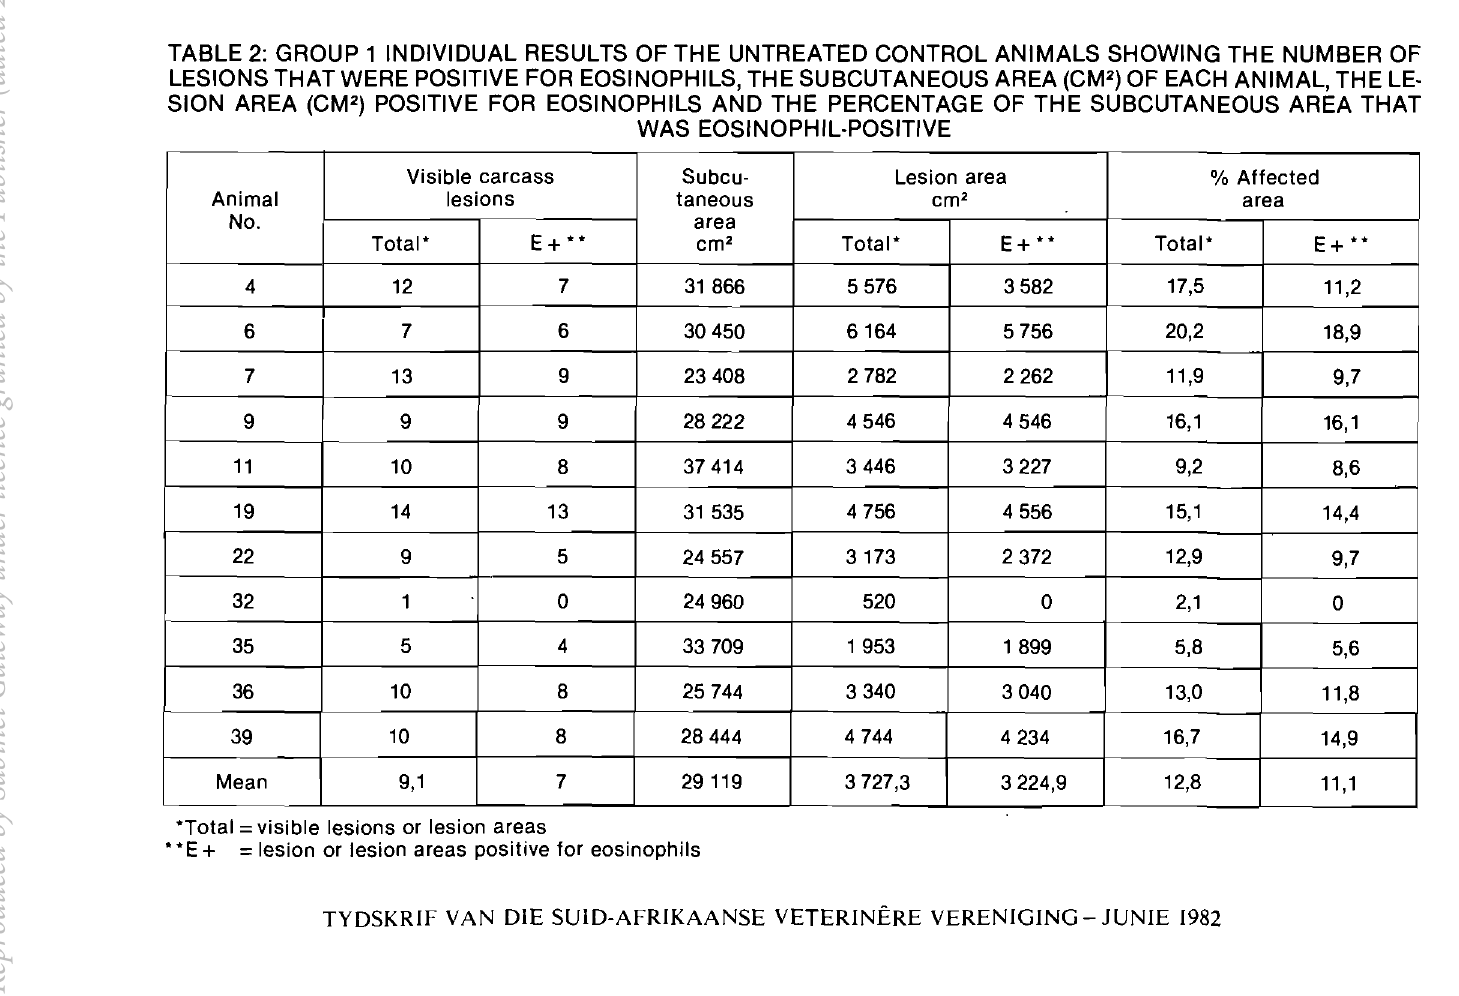
TABLE 2: GROUP 1 INDIVIDUAL RESULTS OF THE UNTREATED CONTROL ANIMALS SHOWING THE NUMBER OF LESIONS THAT WERE POSITIVE FOR EOSINOPHILS, THE SUBCUTANEOUS AREA (CW) OF EACH ANIMAL, THE LE SION AREA (CW) POSITIVE FOR EOSINOPHILS AND THE PERCENTAGE OF THE SUBCUTANEOUS AREA THAT WAS